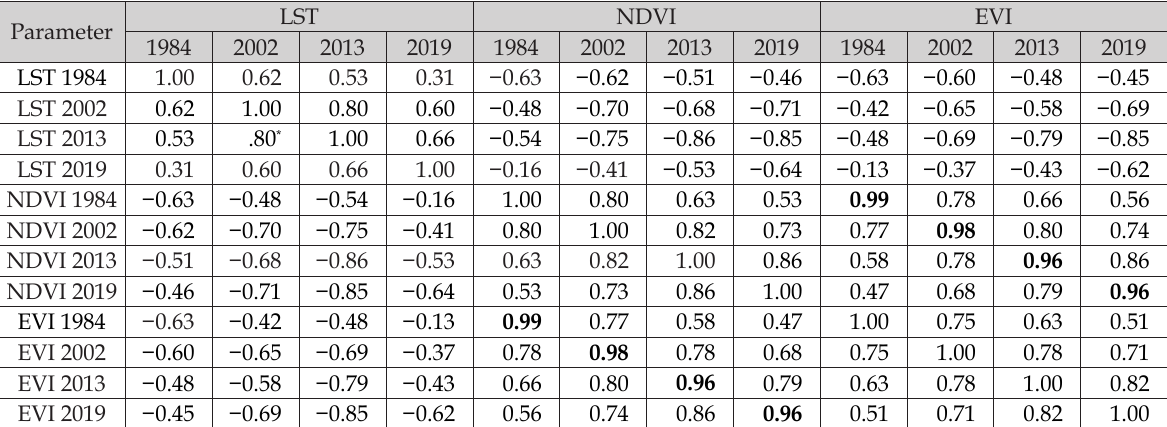
Table 9. Coefficient of correlation ( r ) between LST, NDVI and ENVI in years 1984, 2002, 2013 and 2019. Parameter